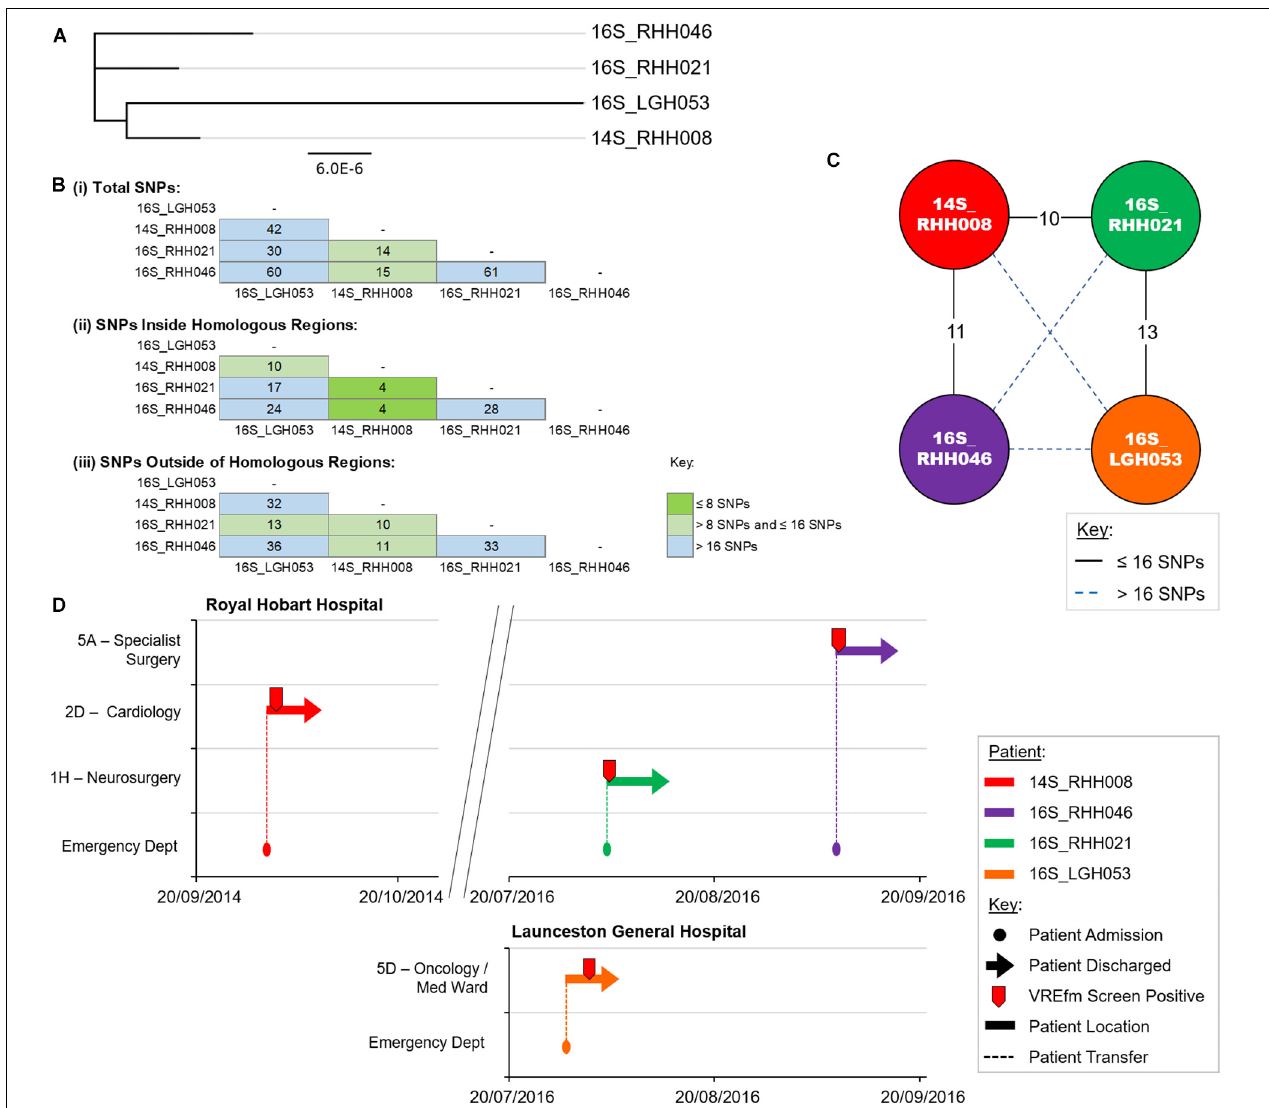
FIGURE 5 | Phylogenetic analysis of vancomycin-resistant Enterococcus faecium (VREfm) isolates from ST1421 Cluster 1. (A) A SNP-based maximum-likelihood (PhyML) phylogenetic tree. (B) Matrix of pairwise comparison of SNP differences between isolates expressed as: (i) Total number of SNP differences; (ii) Number of SNPs inside homologous recombination regions, and (iii) Number of SNPs outside of homologous recombination regions. The previously described recombination-filtered SNP threshold of ≤ 16 SNPs for VREfm has been used as a guide for identifying clonally related or non-unique isolates. (C) Overview of recombination-filtered SNPs between isolates. The numbers of different SNPs between the isolates are shown on the solid black connecting lines. SNP differences above the threshold of 16 SNPs are shown as blue dotted lines. (D) Spatio-temporal location of patients in Cluster 1 who tested positive for VREfm at the Royal Hobart Hospital and Launceston General Hospital. The movement of patients following admission to the Royal Hobart Hospital through to date of discharge are indicated with respect to time ( x -axis) and hospital ward location ( y -axis). Each line color represents an individual patient. Patient 14S_RHH008 was admitted to RHH on September 30, 2014 and was screened for VREfm on October 1, 2014 from which a positive test was